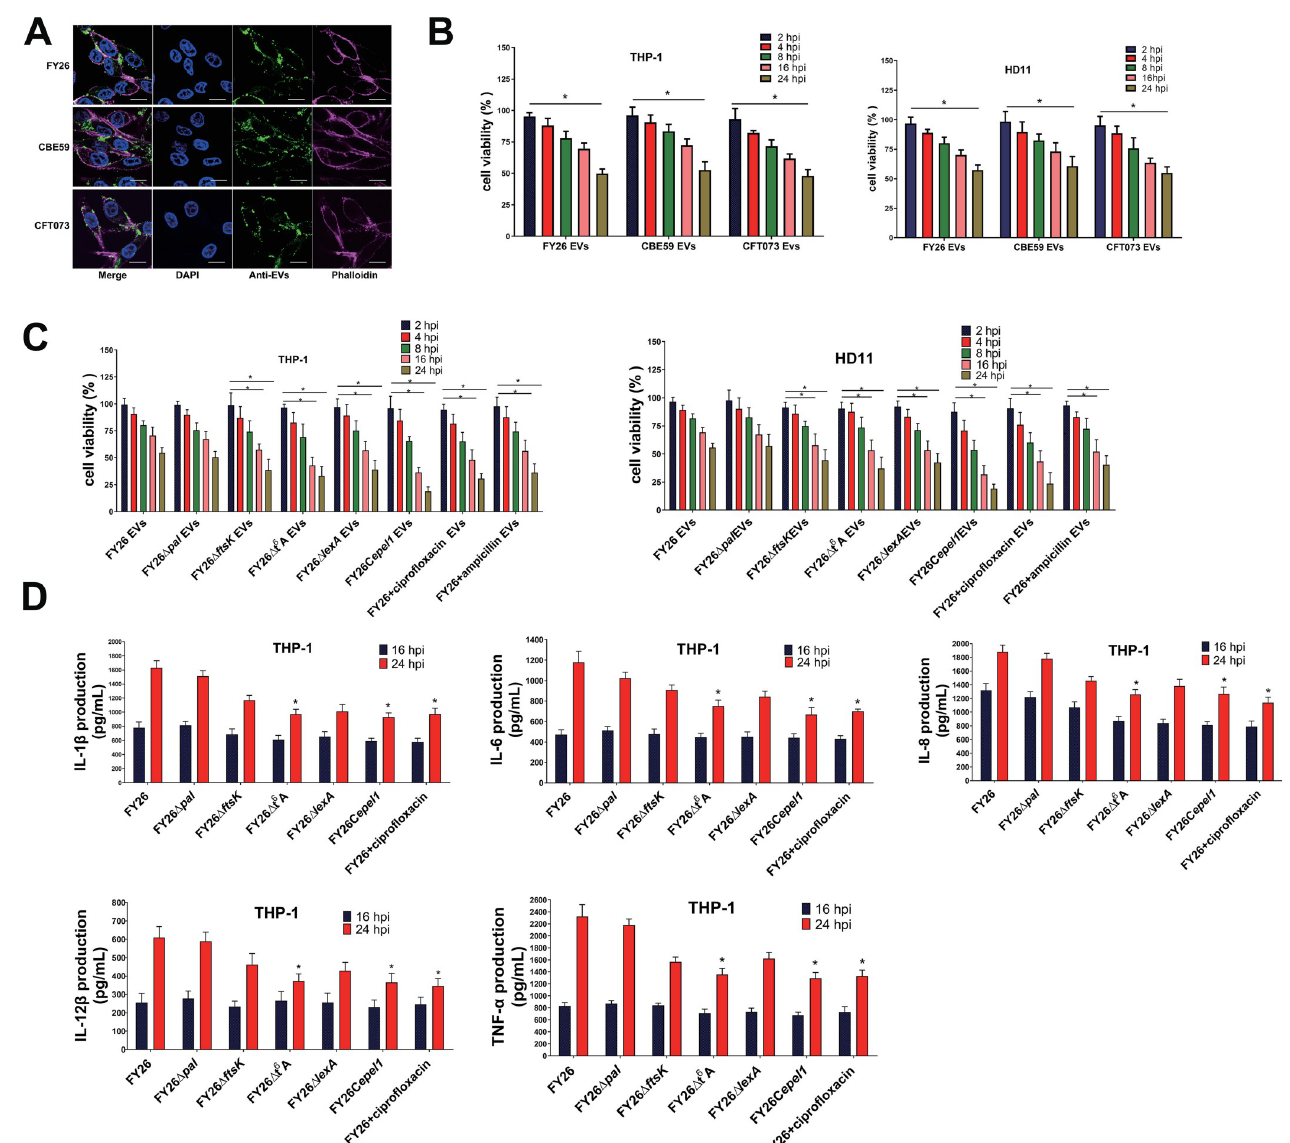
Fig 13. Cytotoxicity of ExPEC EVs. (A) Confocal microscopic visualization of the internalization of ExPEC EVs into HD11 macrophages. Infected HD11 cells were incubated with anti-ExPEC antibody, and stained with FITC-conjugated goat anti-mouse IgG antibody (green), phalloidin (red), and DAPI (blue). Images show a representative of at least three independent experiments. Scale bar: 10 μ m. (B) To investigate the cytotoxic effects of ExPEC EVs on THP-1 and HD11 macrophages, THP-1 or HD11 cells were incubated with EVs (50 μ g/mL) for different periods (2, 4, 8, 16, or 24 h). Cell viability was measured with a CCK-8 kit. The results are presented as means ± SEM of at least three independent experiments. One-way ANOVA was used to evaluate statistical significance ( � P < 0.01). (C) To investigate the cytotoxic effects of ExPEC EVs on THP-1 and HD11 cells, EVs were isolated from mutant strains FY26 Δ ftsK , FY26 Δ t6A, and FY26 Δ lexA , the endolysin-overexpressing strain FY26Cepel1, and antibiotic-treated strain FY26. (D) The cytokines (IL-1 β , IL-6, IL-8, IL-12 β , and TNF- α ) from the cell-free supernatant of THP-1 macrophages was measured using the commercial cytokine ELISA kits. The results are presented as means ± SEM of at least three independent experiments. One-way ANOVA was used to evaluate statistical significance ( � P < 0.01). points. The cytotoxic effect of WT FY26 EVs on THP-1 macrophages was observed at 8 h post-infection (hpi), and macrophage viability was markedly reduced at 24hpi (Fig 13B). A similar cytotoxic phenomenon was also observed when THP-1 macrophages were treated with CBE59 or CFT073 EVs (Fig 13B). Similarly, a cytotoxic effect on HD11 macrophages